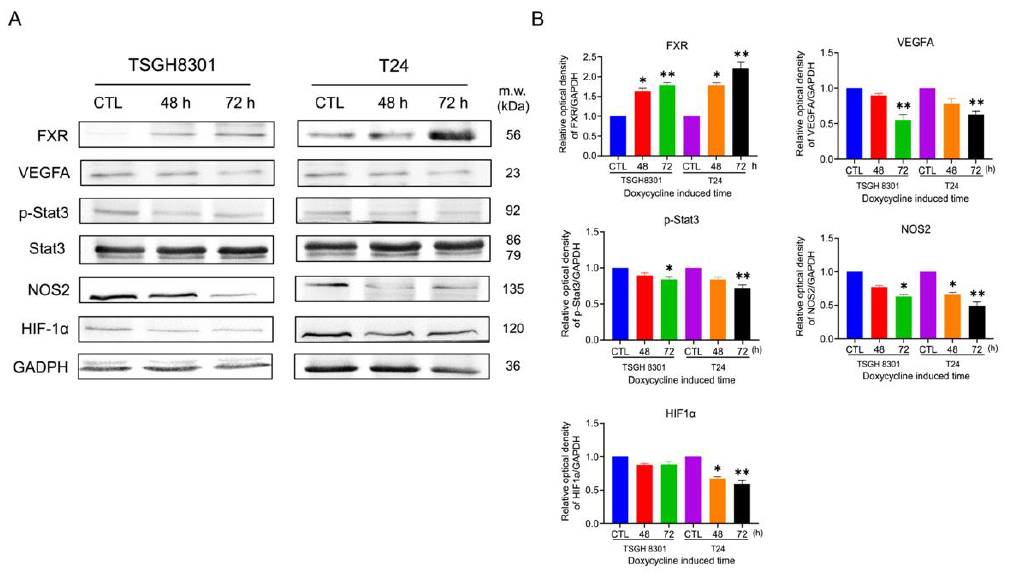
Figure 8. The effect of the overexpression of FXR on angiogenic related protein expression. ( A ) The expression of VEGFA, signal transducer and activator of transcription 3 (STAT3), phospho-Stat3 (p-STAT3), nitric oxide synthase 2 (NOS2) and hypoxia-inducible factors-1α (HIF-1α) were analyzed by Western blotting in TSGH 8301 and T24 cells after FXR overexpression. GAPDH was used as the loading control. ( B ) The bar graphs show the relative quantitative analysis of the aforementioned proteins. * p < 0.05; ** p < 0.01 compared with the control group.